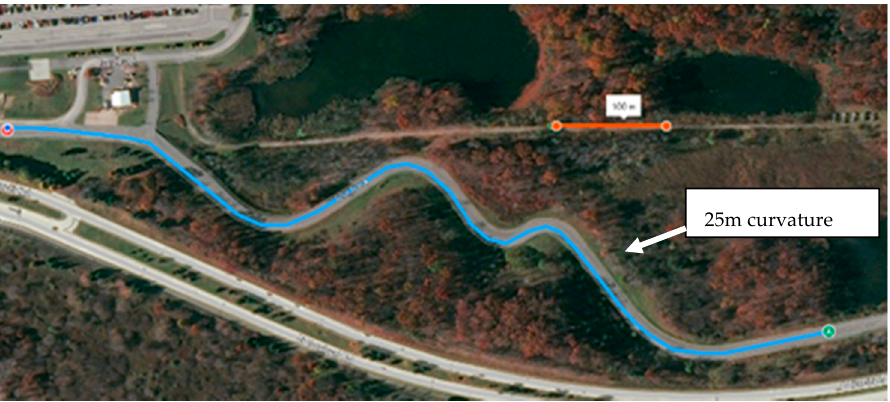
Figure 1. Example of a curvy road where indirect glare from the side rearview mirror is experienced by the preceding driver. ©2021 Microsoft Corporation, ©2021 TomTom.